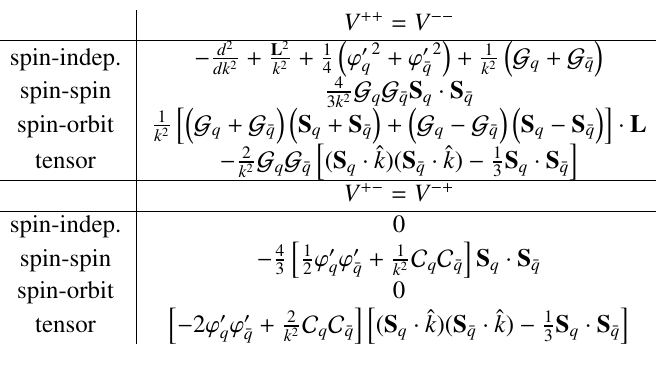
Table 1. The positive and negative energy spin-independent, spin-spin, spin-orbit and tensor potentials are shown. ϕ (cid:8) ( k ), C ( k ) and G ( k ) = 1 − S ( k ) are functions of the quark mass m c ( k ). V ++ = V −− spin-indep.